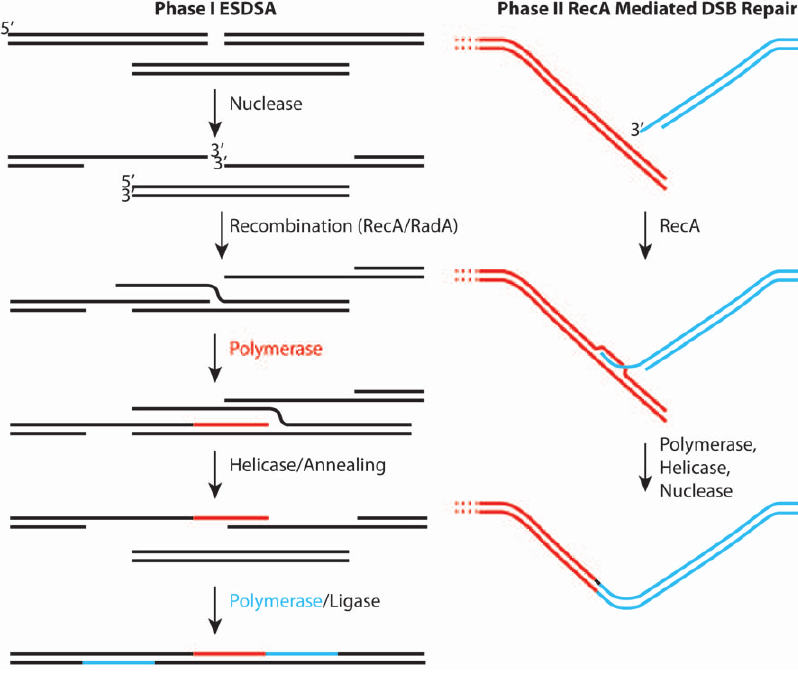
Figure 1. Two stages of genome reconstitution in Deinococcusradiodurans . The first stage, extended synthesis-dependent single-strand annealing (ESDSA) is dominated by nuclease and DNA polymerase functions. The second stage is a more conventional RecA-mediated double- strand break repair process focused on the final splicing of large chromosomal